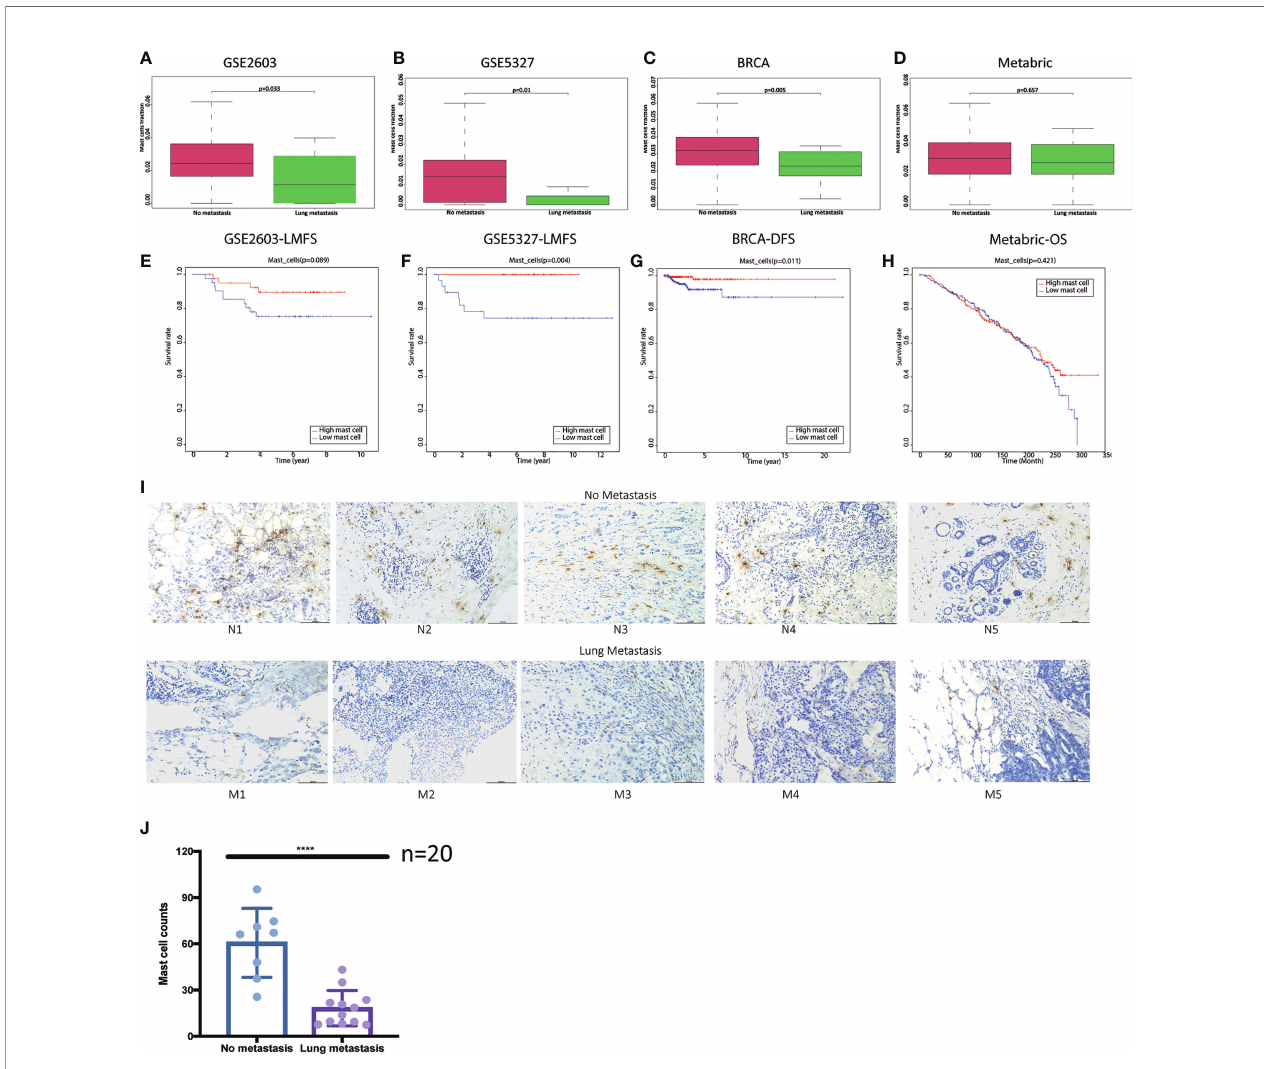
FIGURE 4 | Breast cancer patients with lung metastasis have lower mast cell counts. Distributions of mast cell fractions with respect to lung metastasis status in (A) the GSE2603 cohort, (B) the GSE5327 cohort, (C) the TCGA cohort, and (D) the METABRIC cohort. (E) Representative images of IHC analysis of Tryptase protein in the 10 human breast invasive tumors. Scale bars, 100 m m. (F) Mast cell counts in the no metastasis group were signi fi cantly higher than the lung metastasis group. Student ’ s t test was used to analyze the signi fi cant differences. Kaplan-Meier curves of LMFS of breast cancer patients strati fi ed by mast cell fraction in the (G) the GSE2603 cohort and (H) the GSE5327 cohort. Kaplan-Meier curves of DFS of breast cancer patients strati fi ed by mast cell fraction in the (I) TCGA cohort. Kaplan-Meier curves of OS of breast cancer patients strati fi ed by mast cell fraction in the (J) METABRIC cohort. BRCA, breast invasive carcinoma; METABRIC, molecular taxonomy of breast cancer international consortium; TCGA, the cancer genome atlas; N1-5, patients without metastasis 1-5; M1-5, patients with lung metastasis 1-5; DFS, disease-free survival; OS, overall survival; LMFS, lung metastasis-free survival; ****: p < also had higher CTA, higher mutation burden, and higher ( Figure 5B ), 0.798 in the GSE5327 cohort ( Figure 5C ), 0.708 in the TCGA cohort ( Figure 5D ), and 0.521 in the METABRIC cohort ( Figure 5E ). It was comparable or even superior to other parameters used in metastasis prediction like tumor size, positive lymph nodes number, grade, TNM staging system, and signature HRD score ( Figure 5H ). Differentially mutated genes between reported by another study (18). Then we used mast cell fractions the two subtypes were explored. TP53 was signi fi cantly more to stratify breast cancer patients into two subtypes (subtype 1: low mast cell group and subtype 2: high mast cell group). We found the proliferation score, the wound healing score, and intratumor heterogeneity were all signi fi cantly higher in the low mast cell subtype ( Figure 5F ). The low mast cell subtype